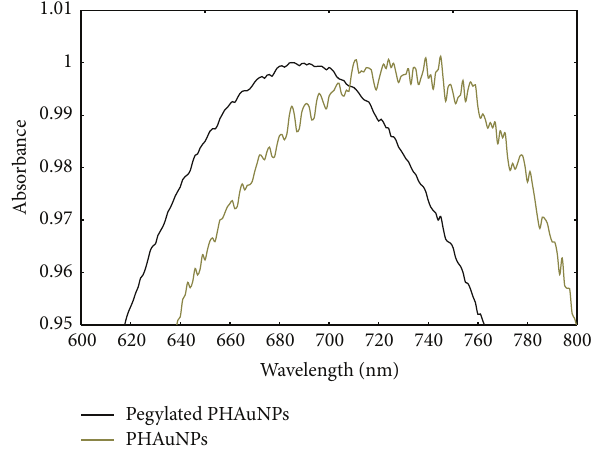
Figure 2: The extinction spectra of bare and pegylated PHAuNPs indicating a blue